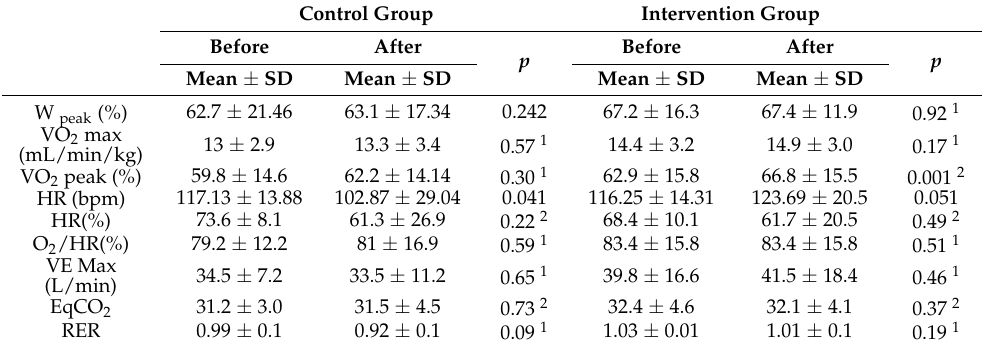
Table 3. Cardiopulmonary exercise test.